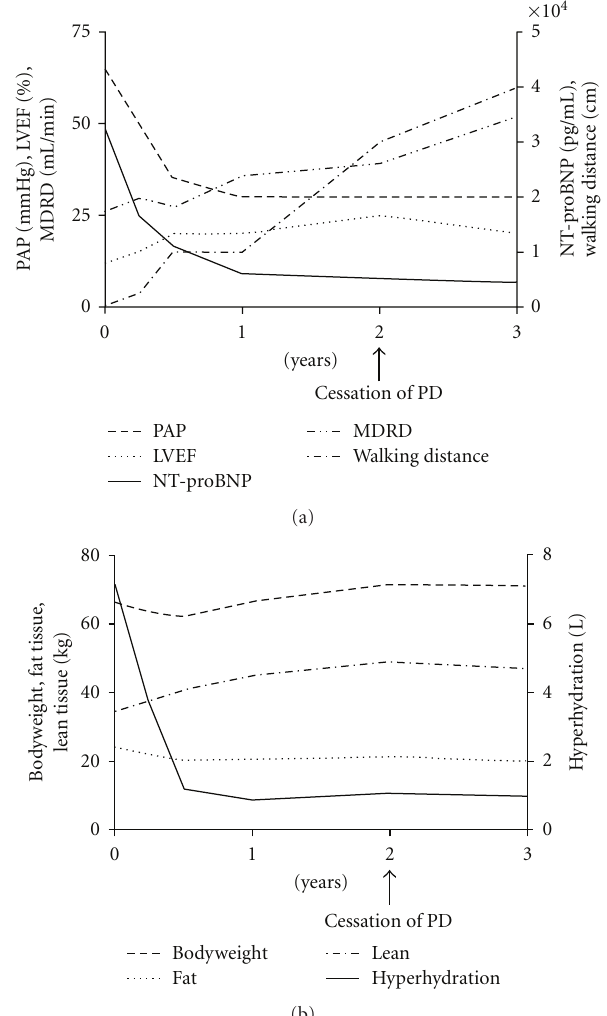
Figure 1: (a) Time course of pulmonary artery pressure (PAP), left ventricular ejection fraction (LVEF), and N-terminal probrain natriuretic peptide (NT-proBNP), residual renal function (MDRD), and walking distance after the initiation of peritoneal dialysis treatment. (b) Time course of bioimpedance measurement with the Body Composition Monitor regarding hyperhydration, body- weight, lean tissue mass, and fat tissue mass after the initiation of peritoneal dialysis treatment. kidney function with a clearance of 26 mL/min/1.73 m